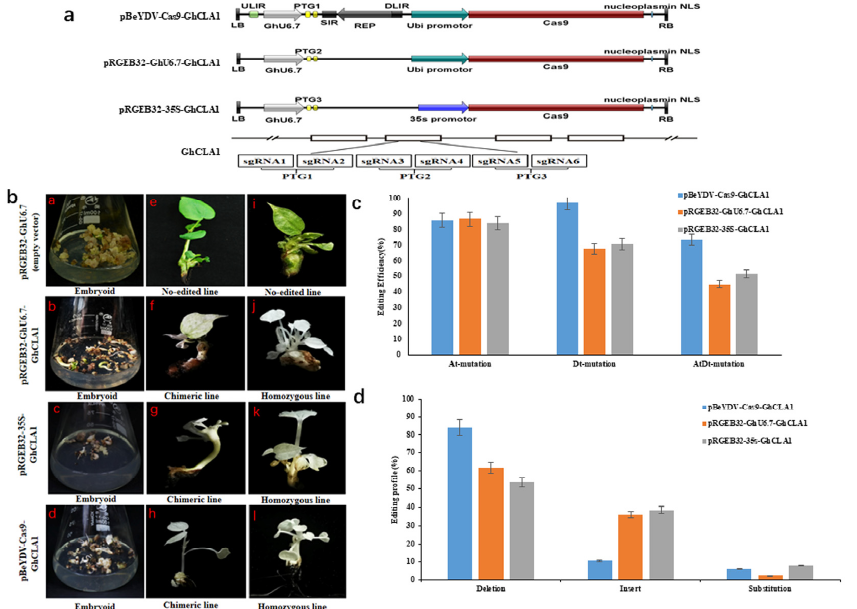
Figure 2. Comparison of editing efficiency of different genome editing vectors in cotton. ( a ) The schematic diagram of pBeYDV-Cas9-GhCLA1, pRGEB32-GhU6.7-GhCLA1, and pRGEB32-35S- GhCLA1 vectors. GhCLA1: Target gene. PTG: Polycistronic tRNA-gRNA, PTG1: tRNA-sgRNA1- tRNA-sgRNA2, PTG2: tRNA-sgRNA3-tRNA-sgRNA4, PTG3: tRNA-sgRNA5-tRNA-sgRNA6. ( b )